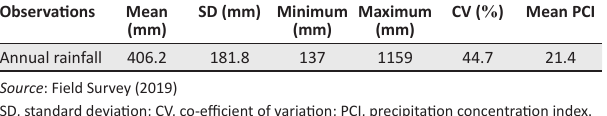
TABLE 4: Descriptive statistics of annual rainfall in Harshin, 1983–2017.